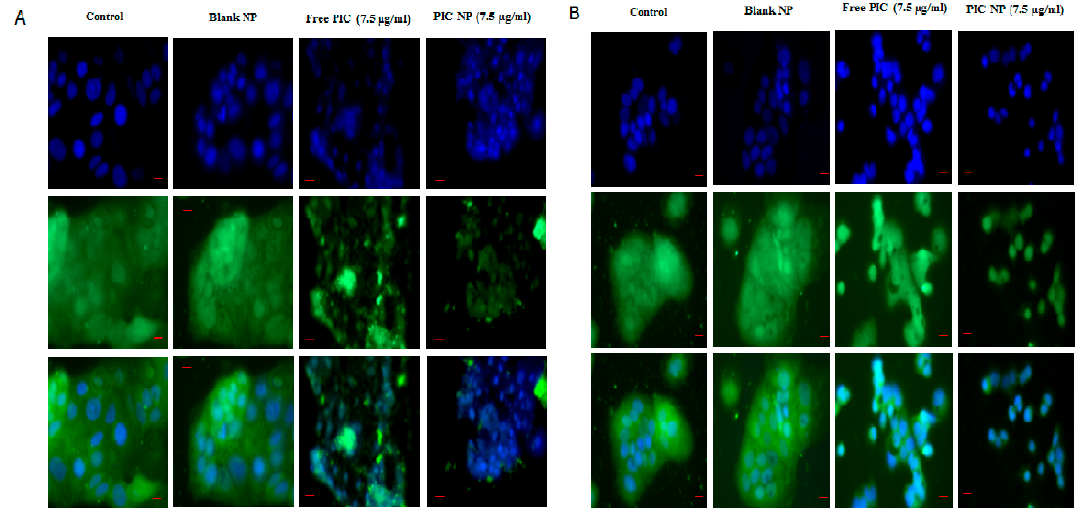
Figure 5. Effect of PIC-loaded albumin nanoparticles on the expression of p65. Effect of PIC-loaded albumin NPs and free PIC on the expression of p65 in CaCo-2 at 40×. ( A ) were captured under bright field microscopy. Control and blank images show induction of p65, whereas images under free PIC and PIC-loaded albumin NPs show a reduced level of p65. ( B ) shows a significant ( p < 0.01) reduction in the level of p65. Values are mean ± SEM ( n = 3). * p < 0.05 and ** p < 0.01 as compared to control. ΔΔ p < 0.01 compared to same amount of free PIC. Similarly Figure 5 C shows images captured under bright field microscopy in HT-29 cells at 40X. Control and blank images show induction of p65 whereas images under the free PIC and PIC-loaded albumin NP show a reduced level of p65. The Figure 5D reveals significant reduction in the level of p65. Values are mean ± SEM ( n = 3). ** p < 0.01 and *** p < 0.001 as compare to control. ΔΔΔ p < 0.001 compared to same amount of free PIC.